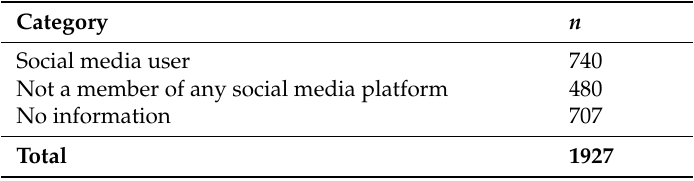
Table 1. Social media usage among survey respondents ( n = 1927).